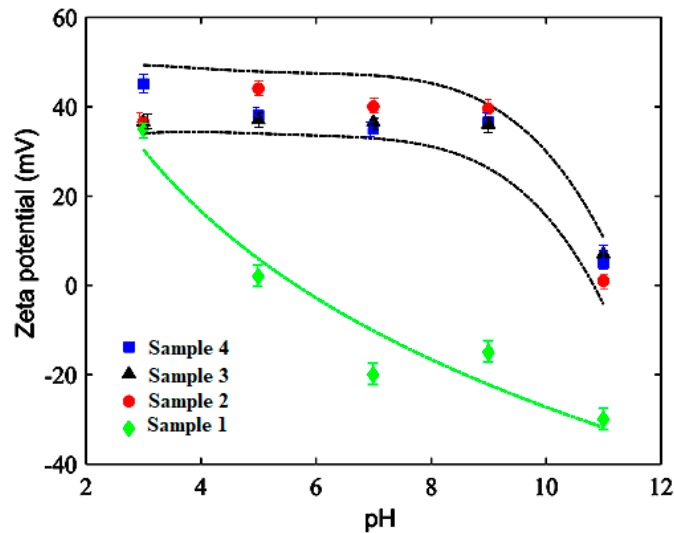
Figure 3. Zeta potential of uncoated cobalt ferrite nanoparticles (sample 1) and aminodextran-coated cobalt ferrite nanoparticles (samples 2, 3 and 4) as a pH function.